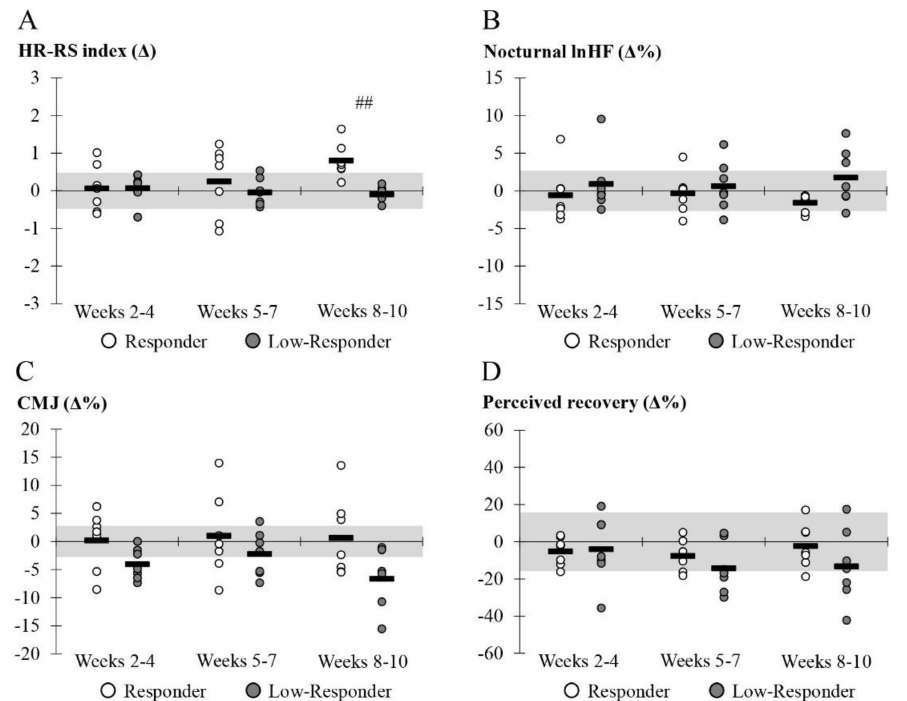
Figure 3. Mean (black line) and individual values (dots) in the relative changes compared to the control period in the nocturnal HRV (lnHF), heart rate-running speed index (HR-RS index), counter- movement jump (CMJ), and perceived recovery. The gray area represents the smallest worthwhile change. ## p < 0.01 in between-group